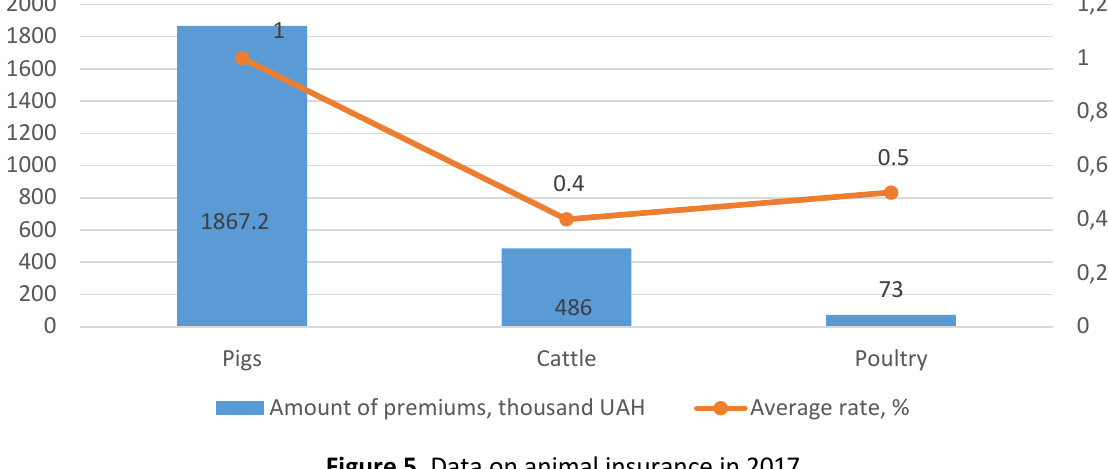
Figure 5. Data on animal insurance in